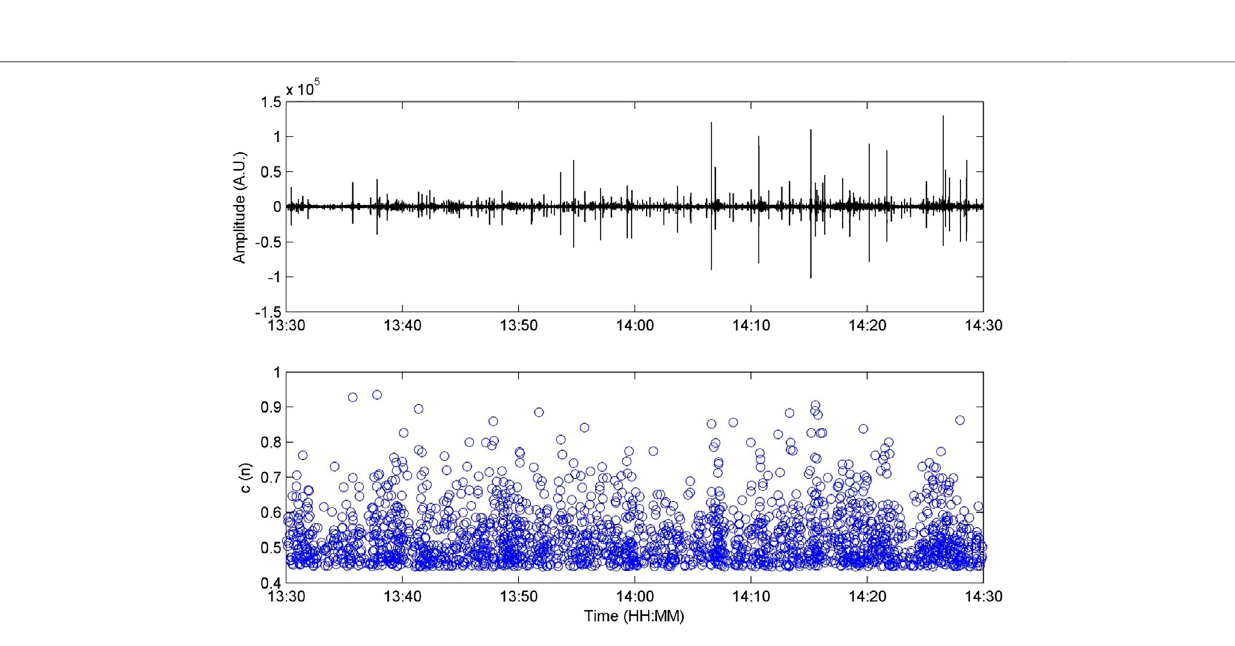
Frontiers in Earth Science |